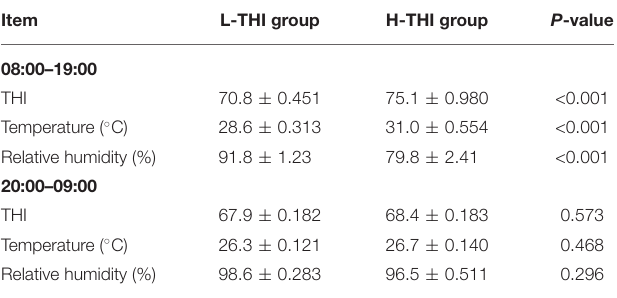
TABLE 1 | Environmental parameters (Mean ± SE).